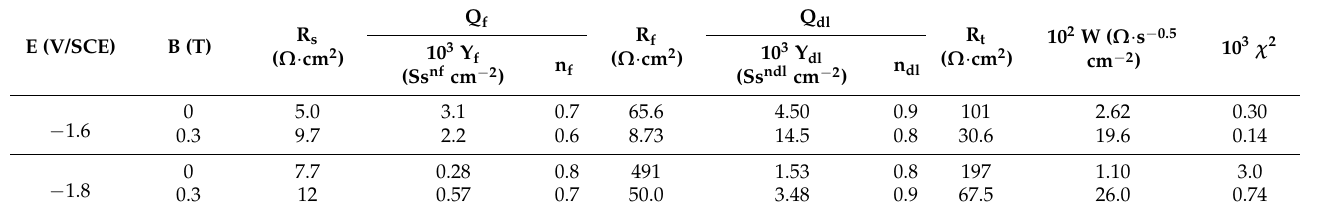
Table 3. Optimum fit parameters for Zn–Mn alloy deposited as a function of cathodic potential and magnetic field.